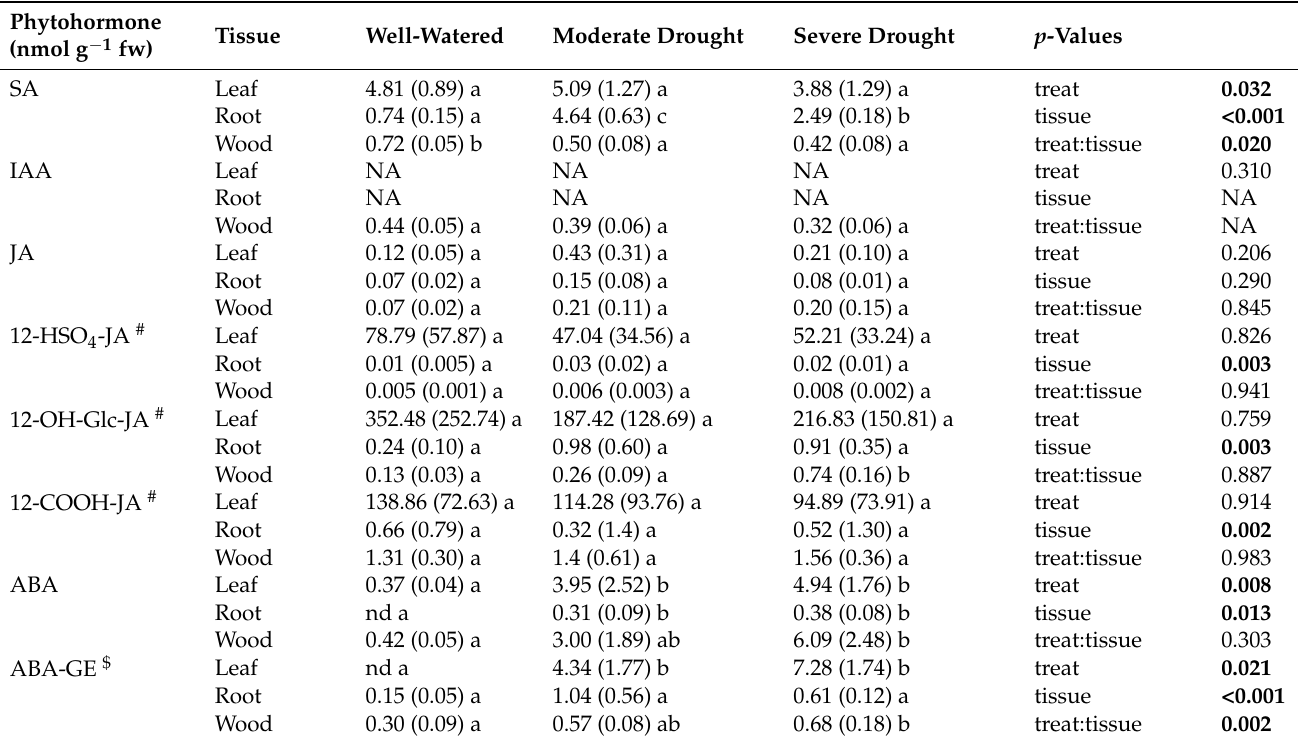
Table 2. Concentrations of phytohormones in leaves, wood, and fine roots of poplar (hybrid T89) in response to drought treatments. Data show means (SE) of n = 3 to 5. Two-way ANOVA was applied to test the difference between tissues and treatments. p -values of comparison between treatments (treat), between leaves, wood, and roots (tissue) and the interaction effect of tissues and treatments (treat:tissue) are listed in the last column. Tukey-test was applied post-hoc for each tissue separately and means that differ at p ≤ 0.05 are indicated by different letters. fw refers to fresh